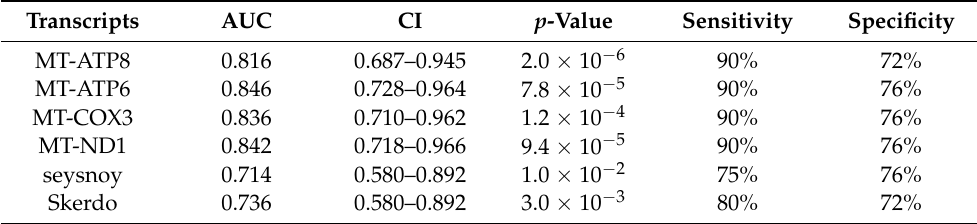
Table 4. p -values and fold-change expression values of selected transcripts analyzed through Real- Time PCR in the validation cohort in G3 versus G2 or G1